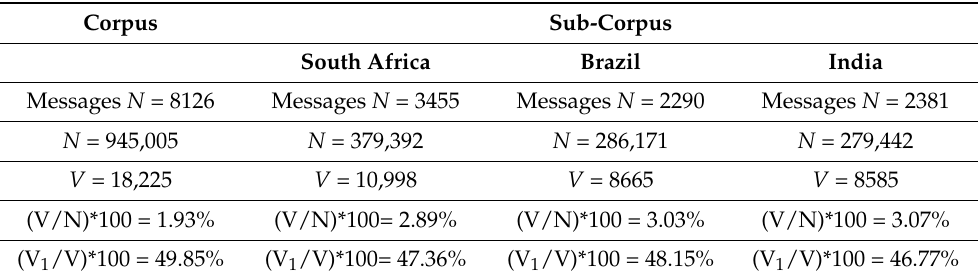
Table 2. Lexicometric characteristics of the corpus and of the subcorpora Legend: N = Tokens, V = Types, V1 = Hapax legomenon. Corpus Sub-Corpus South Africa Brazil